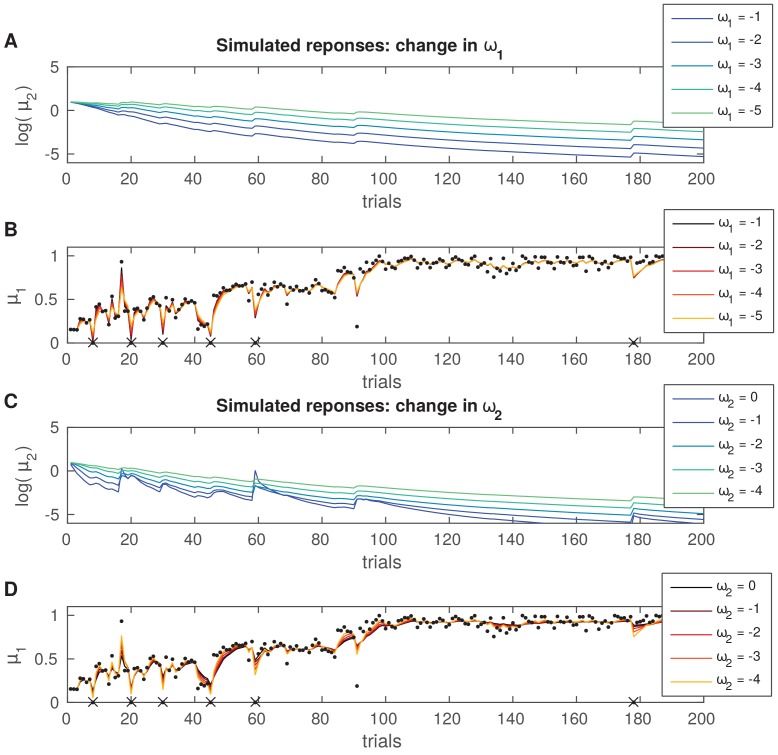
Simulated trial-by-trial belief trajectories in an ideal learner.Simulated trial-by-trialtrajectories of posterior means of belief distributions in an ideal learner with different values of ω1 (A, B) or ω2 (C, D). All trajectories were simulated with identical input scores and parameters, except for ω1 (A, B) or ω2 (C, D): μ1⁢(0)=0.1,μ2⁢(0)=1,σ1⁢(0)=σ2⁢(0)=l⁢o⁢g⁢(1),κ=1,πu=1/35 (precision of input). (A) Increasing values of ω1 (largest value ω1 = −1 in this example) lead to a more pronounced general reduction in the estimate of log-volatility across trials, log(μ2). (B) The time series of the expectation on reward does not vary in a noticeable way as a function of ω1. (C) Increasing values of ω2 (largest value ω2 = 0 in this example) triggered more phasic trial-by-trial changes in the log-volatility estimate, log(μ2), in response to prediction errors at the lower level (PE about reward, indicated by sharp changes in the trajectories of reward expectations in panel [D]). Increasing values of ω2 correspond to higher uncertainty in the prediction on that level (see Equation 13 in 'Materials and methods'). (D) Same as panel (B), but for varying values of ω2. Expectations on reward did not change considerably as a function of ω2 in this example.